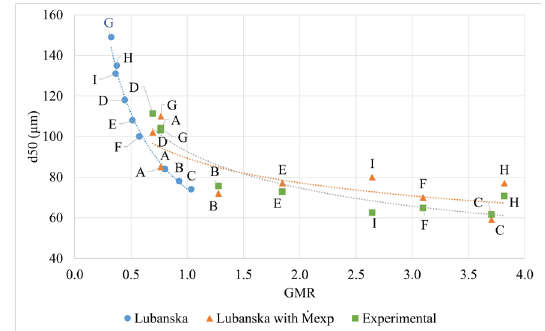
Figure 4. d50 versus GMR.